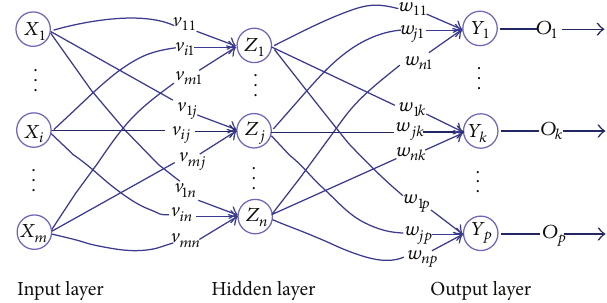
Figure 5: Feed-forward artificial neural network adapted from [9].